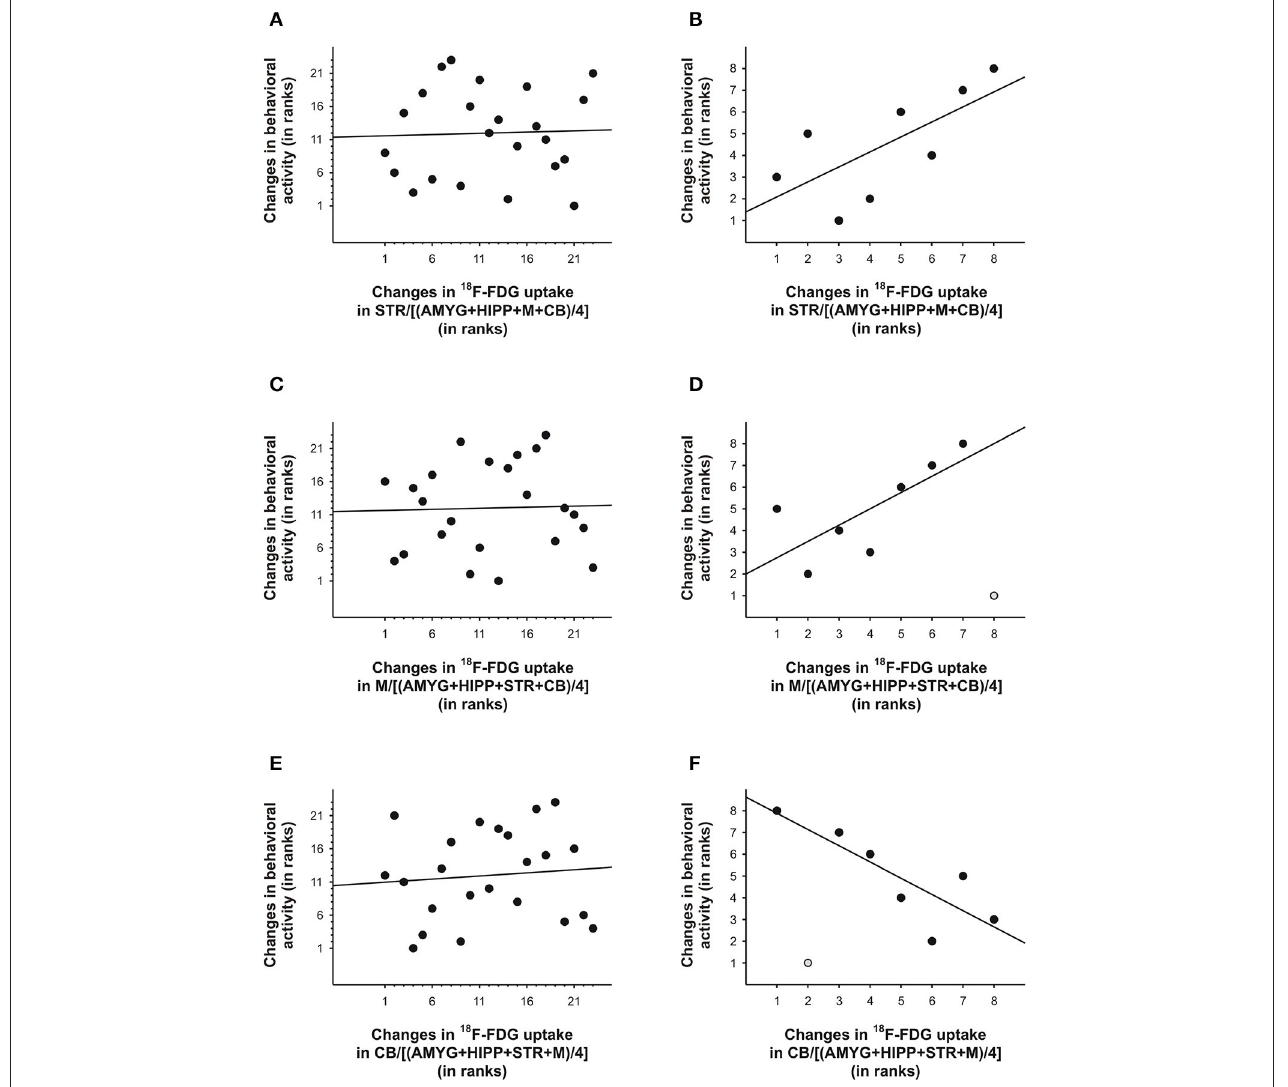
FIGURE 7 | Changes in 18 F-FDG uptake correlated with changes in behavioral activity across scan 1 in rat. We correlated changes in 18 F-FDG uptake, i.e., differences between successive 5min time bins, in the (A,B) striatum (STR), (C,D) motor cortex (M), and (E,F) cerebellum (CB) relative to a reference region (the average uptake in a combination of four ROIs) with changes in behavioral activity for the same time frames. When all 5min time frames ( n = 23) were included for analysis (A,C,E), changes in 18 F-FDG uptake did not significantly predict changes in behavioral activity across time. By contrast, for the time frames ( n = 7–8) near the times of the 18 F-FDG injections (B, D, F), changes in uptake in STR, M, and CB explained a large proportion of the variance in behavioral activity. The data are represented as ranks. Rank 1 indicates the largest decrease, whereas the highest rank indicates the largest increase between any of two successive 5-min-long time frames. When an outlier (light gray) was present (D, F) , the regression line was fitted to the remaining